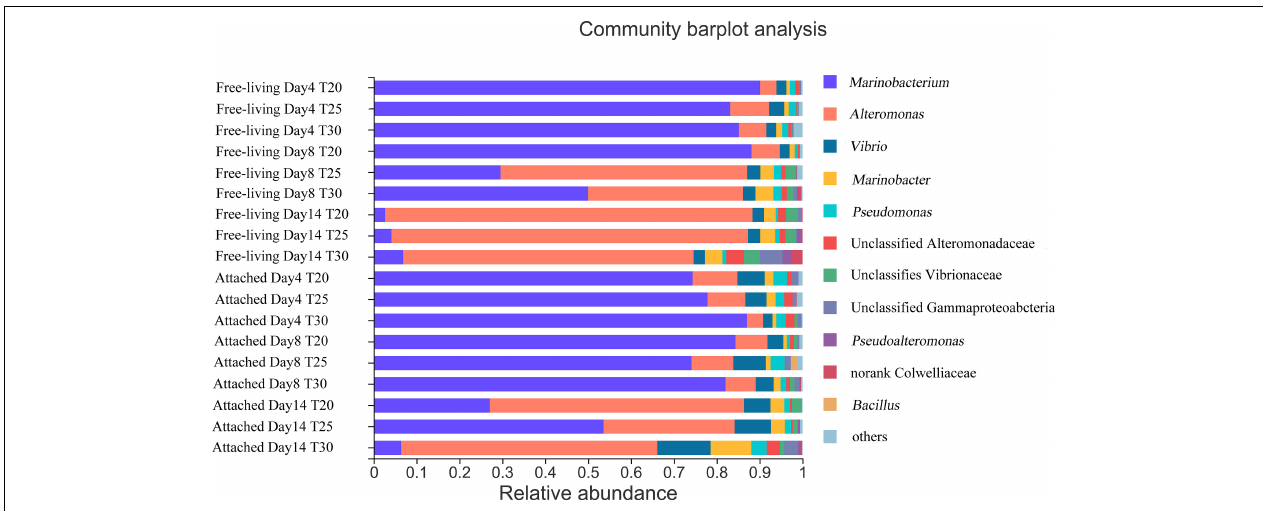
FIGURE 3 | Bacterial composition of the microbial consortium of samples at different time points (days 4, 8, and 14) and at different temperatures (T20, T25, and T30) of free-living and attached bacteria with average value from three replicates for each treatment in genus level.